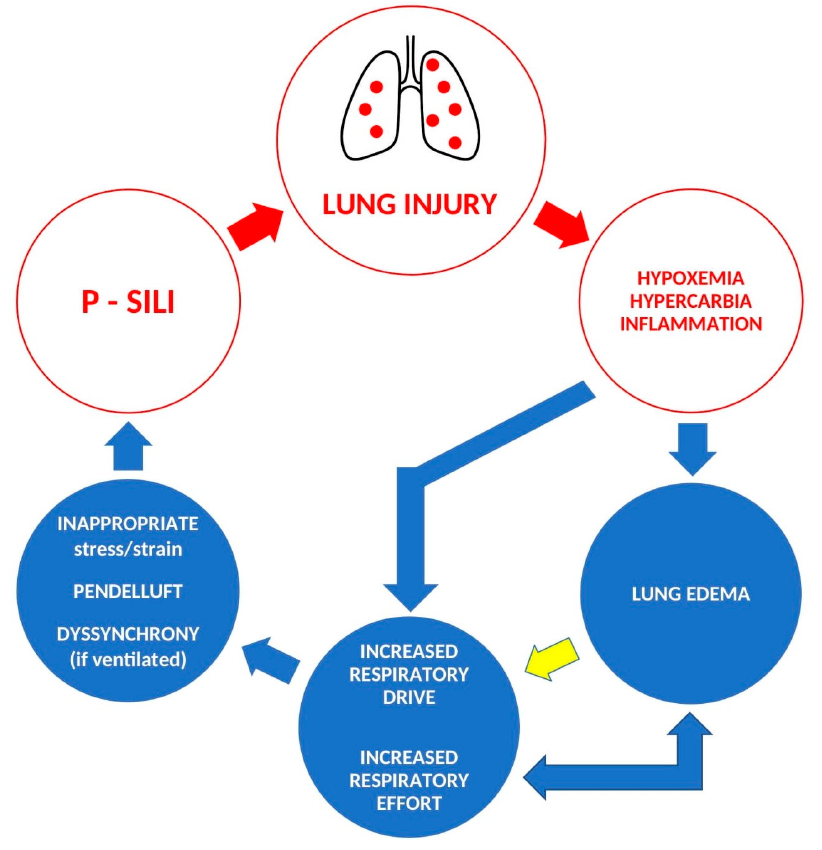
Figure 1. The pathophysiology of P-SILI—a “vicious circle” of self-aggravating lung injury; yellow arrow—vagal signalization (according to [5,10,18] ).